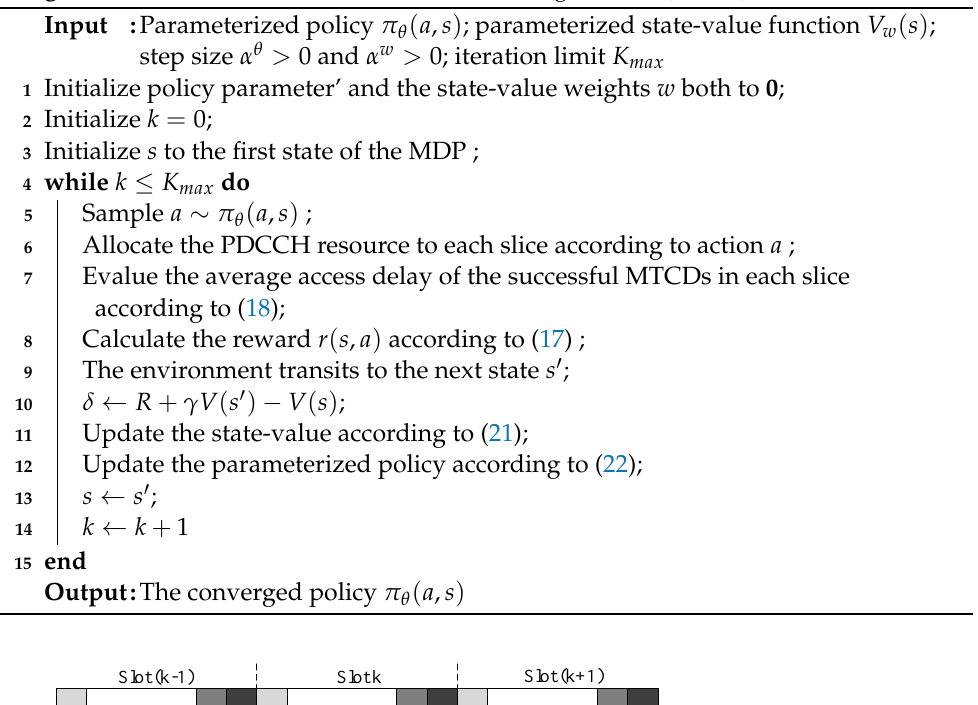
Algorithm 1: Actor-Critic-based Resource Sharing Scheme (ACRS) for DPRAP